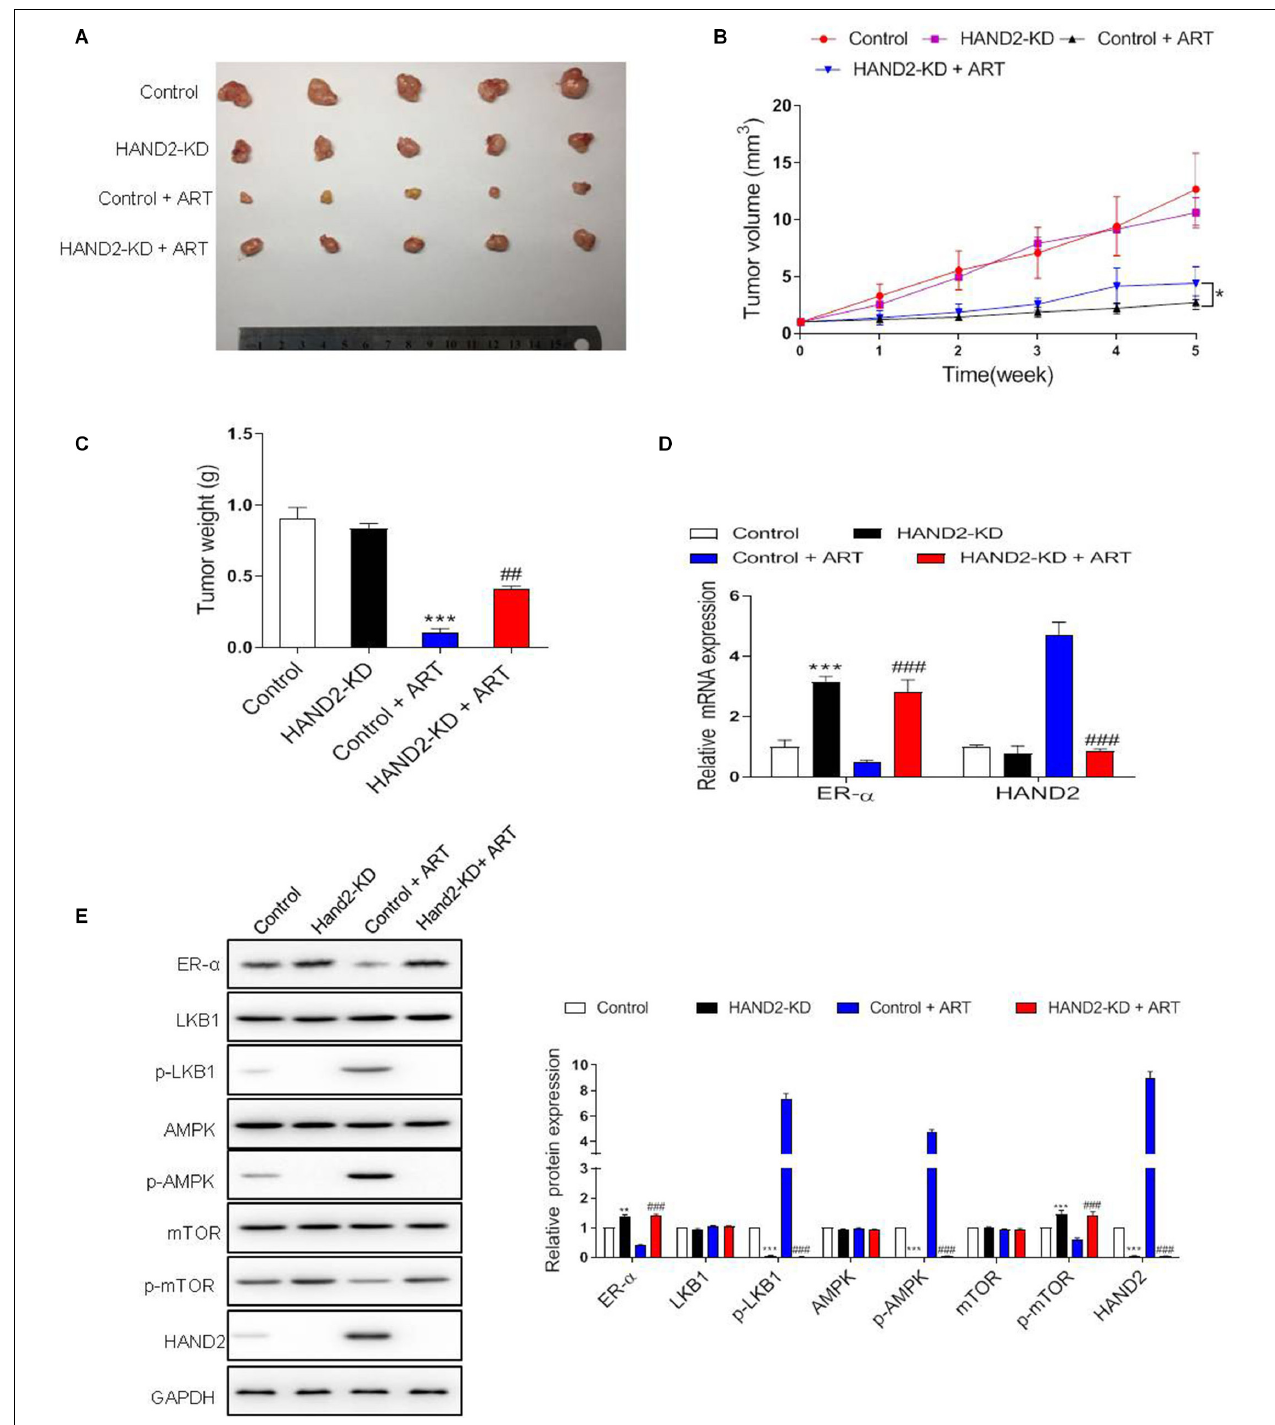
FIGURE 7 | Artesunate (ART) inhibited tumor proliferation via the HAND2 dependent pathway. After transfected with HAND2-KD, the Ishikawa cells injected subcutaneously into mice, followed by ART treatment (30 mg/kg/d, in 200 µ L PBS). (A) Typical photos of tumors from control, HAND2-KD, control + ART, and HAND2-KD + ART groups 5 weeks after injection. (B,C) The tumor volume and weight of these groups. * p < 0.05. (D) The mRNA levels of ER- α and HAND2 were performed by qRT-PCR analysis. (E) Representative blots and analyses were performed for the expressions of ER- α , LKB1, p-LKB1, AMPK, p-AMPK, mTOR, p-mTOR, and HAND2 in the tumor tissues of mice. The data were showed as the mean ± SD, ** p < 0.01, *** p < 0.001 vs. the control group; ## p < 0.01, ### p < 0.001 vs. the control + ART group.